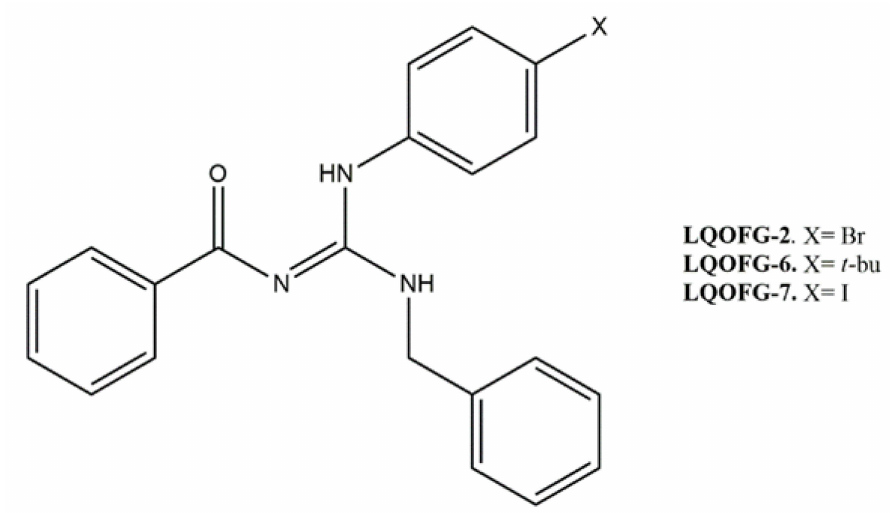
Figure 1. Molecular structure of guanidine derivatives. ( Z )-N-((benzylamine)((4-bromophenyl)amino) methylene)benzamide (LQOFG-2). ( Z )-N-((benzylamine)((4-(tert-butyl)phenyl)amino)methylene)benza- mide (LQOFG-6). ( Z )-N-((benzylamine)((4-iodophenyl)amino)methylene)benzamide (LQOFG-7)